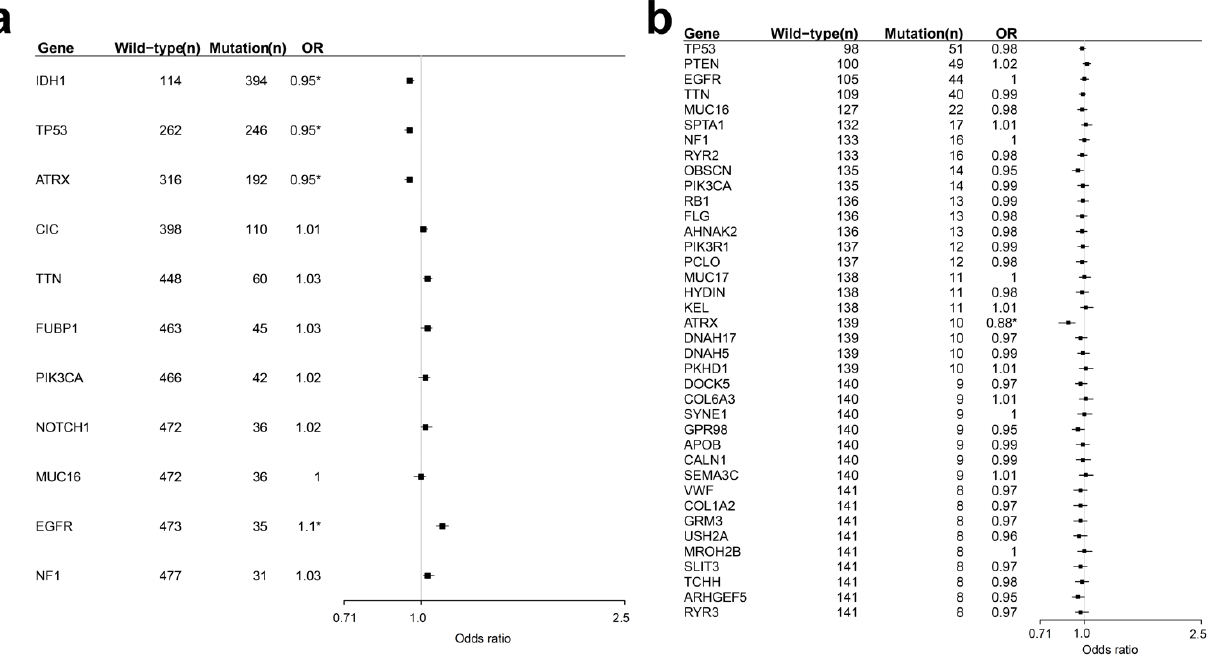
Figure 1. Frequencies of mutated and wild-type genes and logistic regression results showing the relationship of mutations with age in patients with lower grade glioma ( a ) and glioblastoma ( b ). Genes shown have mutation rates >5%. OR, odds ratio; *, significant.